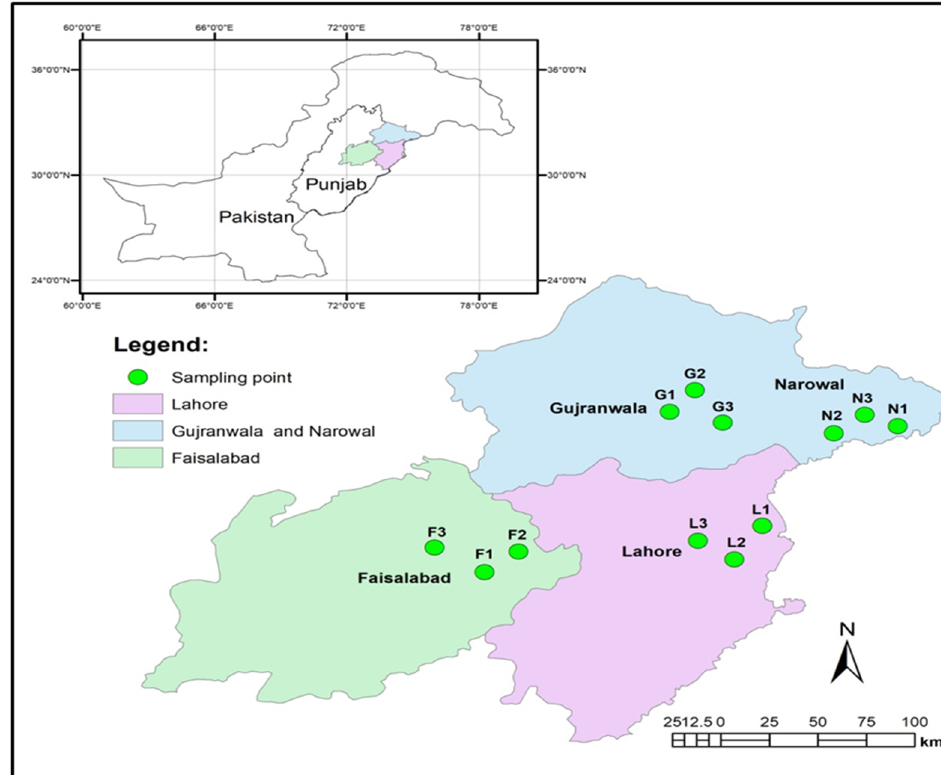
Figure 1. Study sites and sampling points in four rice-growing districts: Lahore, Narowal, Gujranwala, and Faisalabad in Punjab Province.